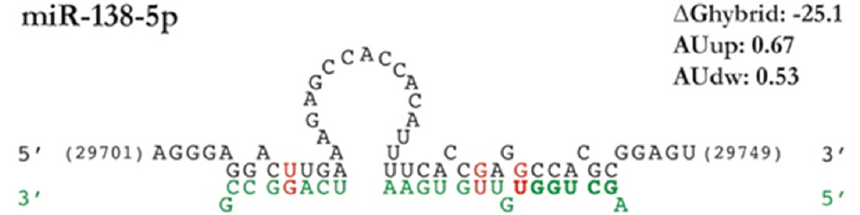
Figure 5. Predicted binding site of hsa-miR-138-5p in the SARS-CoV-2 3 (cid:48) -UTR. The figure summarizes the information provided by STarMir and RNAhybrid on location, sequence complementarity, free energy, target site accessibility, and AU content upstream and downstream. The viral 3 (cid:48) -UTR sequence is written in black, whereas the human microRNA sequence appears in green type, microRNA seed regions appear in bold type, and GU unions are shown in red.